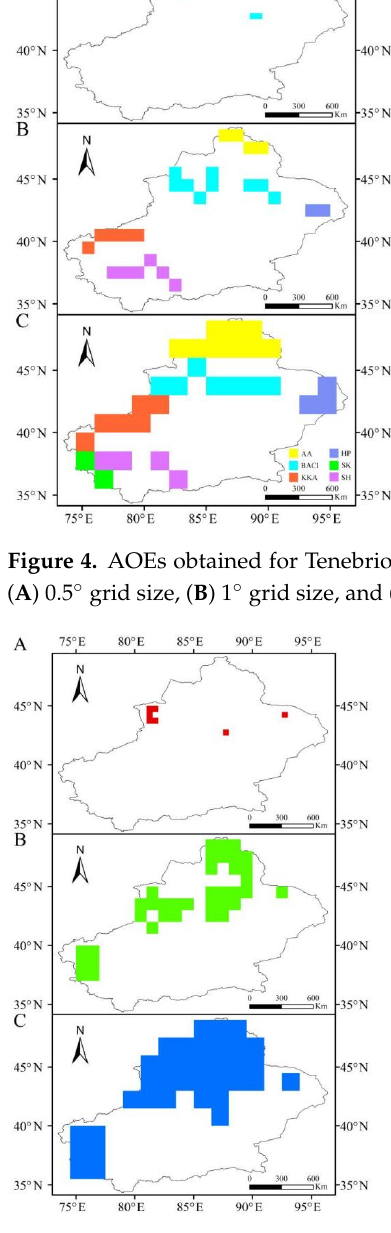
Figure 5. AOEs obtained for Tenebrionidae by EA analysis using three different cells in Xinjiang, China: ( A ) 0.5° grid size (red shadows); ( B ) 1° grid size (green shadows); and ( C ) 1.5° grid size (blue shadows).